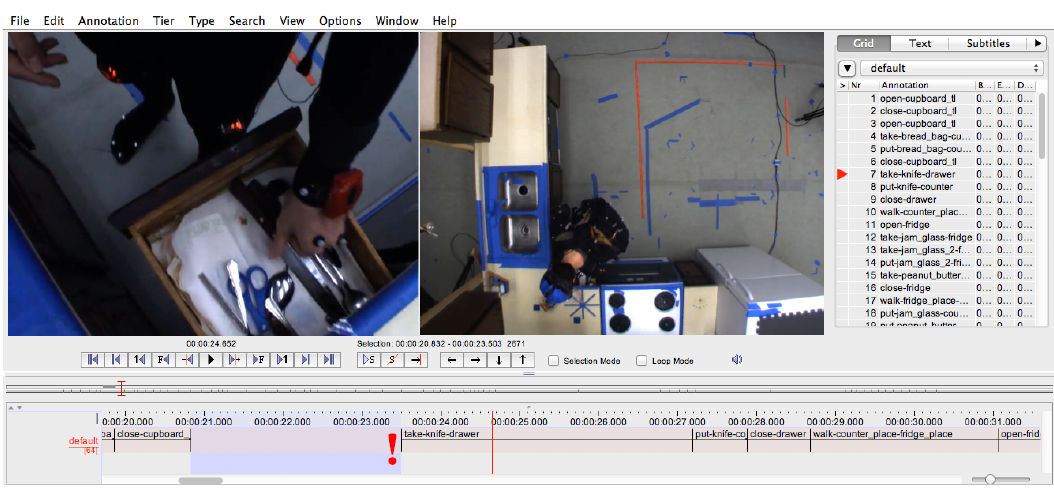
Figure 4. The ELAN tool used to manually create an annotation sequence from the video log. Here, the take-knife-drawer action is being